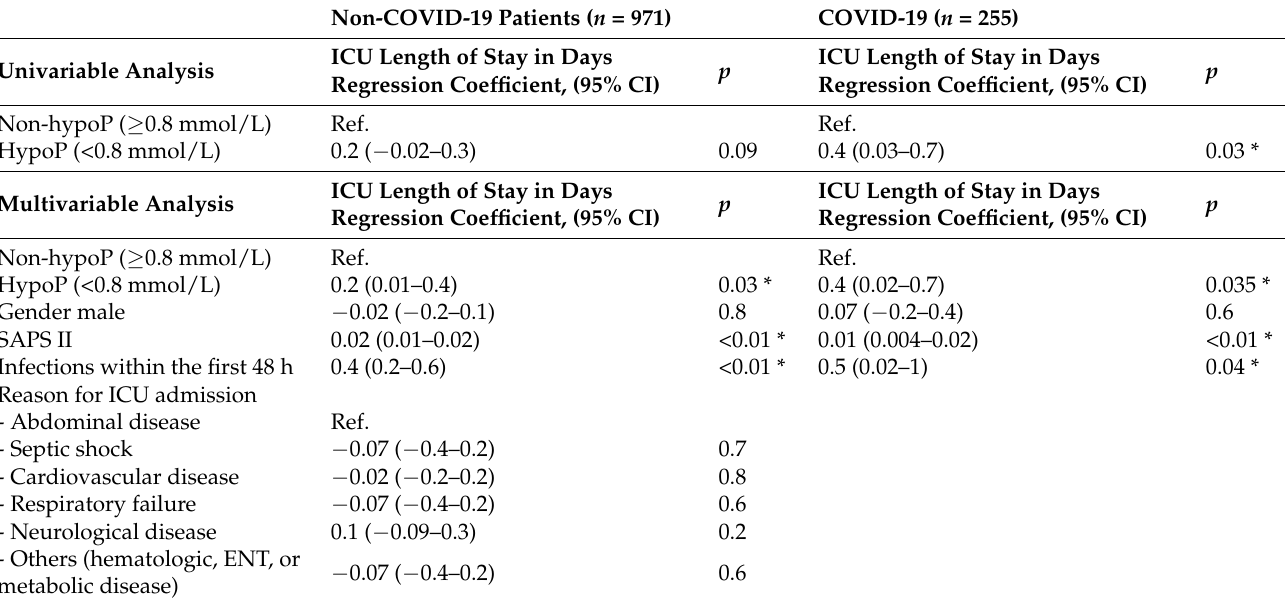
Table A5. Length of stay in the ICU in non-COVID-19 and COVID-19 patients in